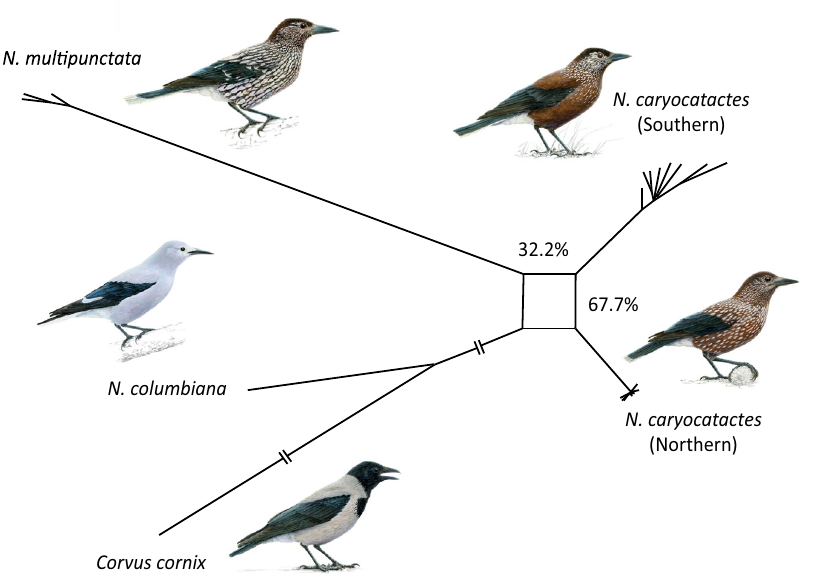
Fig. 2 Evolutionary network of the four nutcracker species and their sisterspecies. Phylogenetic network of the Eurasian nutcracker species complex based on 192 alignments of 1 Mbp of the nuclear genome. The numbers at the branches indicate the percentage of genomic alignments supporting the split. Some branch lengths are shortened for visualization purposes. Bird images by Jon Baldur Hlidberg, courtesy of the authors.